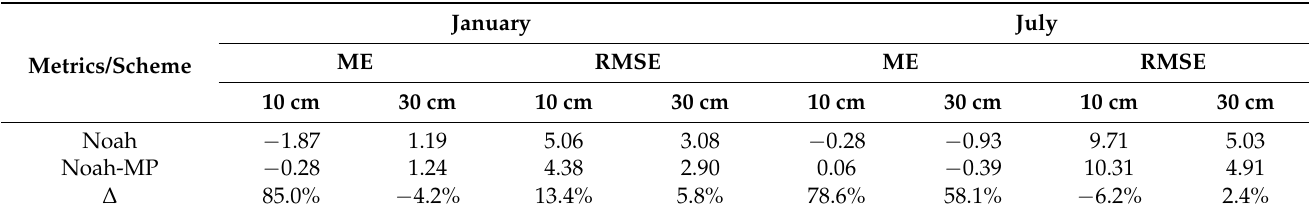
Table 3. ME and RMSE of the simulated soil temperature at 10 cm and 30 cm thickness in WRF simulations with Noah and Noah-MP schemes in January and July 2017 (unit: ◦ C).